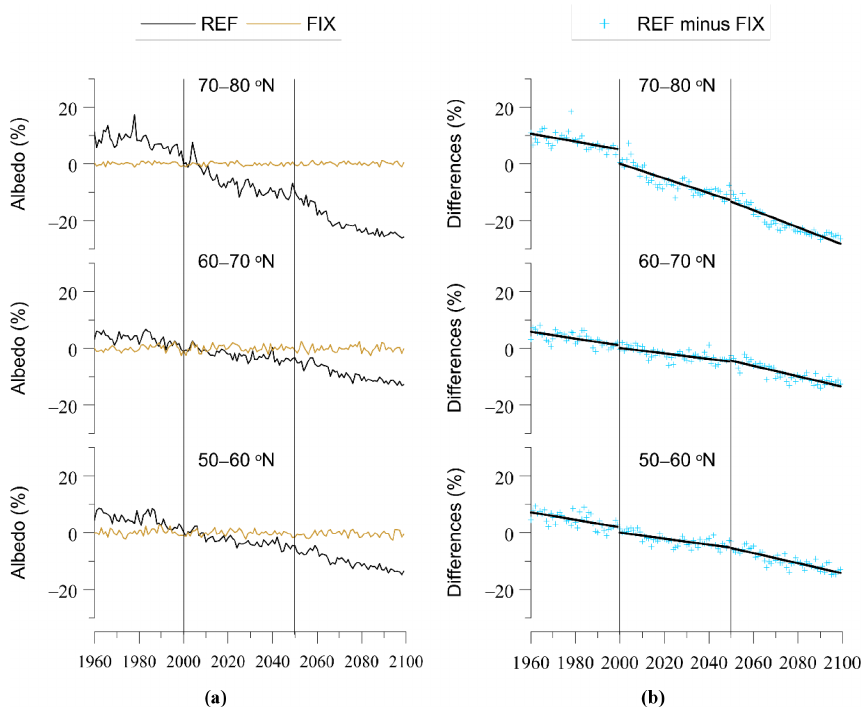
Figure C1. EMAC CCM projections of zonal mean surface albedo for 10 ◦ latitude zones (50–60 ◦ N, 60–70 ◦ N, 70–80 ◦ N), based on simulations with increasing and fixed-GHG mixing ratios. (a) REF is the simulation with increasing GHGs according to RCP 6.0. FIX is the simulation with fixed-GHG emissions at 1960 levels. (b) Difference between the two model simulations, as an indicator of the impact of increasing GHGs. The y axis in (a) shows yearly averaged surface albedo data (in %) calculated from de-seasonalized monthly data. The monthly data were de-seasonalized relative to the long-term monthly mean (1990–2019) and were expressed in percent. For the northern high latitudes, the annual average refers to the average of monthly anomalies from March to